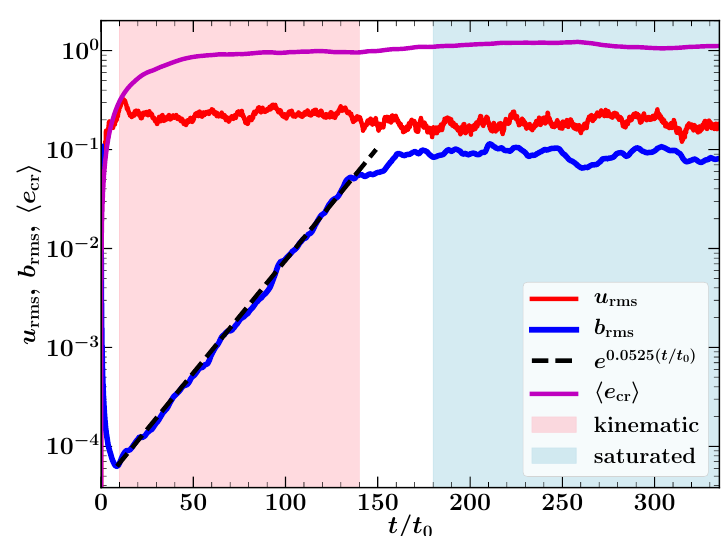
Figure 7. Time evolution of the rms velocity field u rms (red), rms magnetic field b rms (blue) and mean cosmic ray energy density (cid:104) e cr (cid:105) (magenta) as a function of normalized time t / t 0 , where t 0 is the eddy turnover time, for the case where (cid:104) e cr (cid:105) > b 2 rms . The magnetic field decreases until it transforms into an eigenfunction of the induction equation, and then, it grows exponentially (kinematic stage, light pink). The magnetic field finally saturates (saturated stage, light blue) due to the back reaction on the velocity flow by Lorentz forces. The cosmic ray energy density saturates faster than the magnetic field.